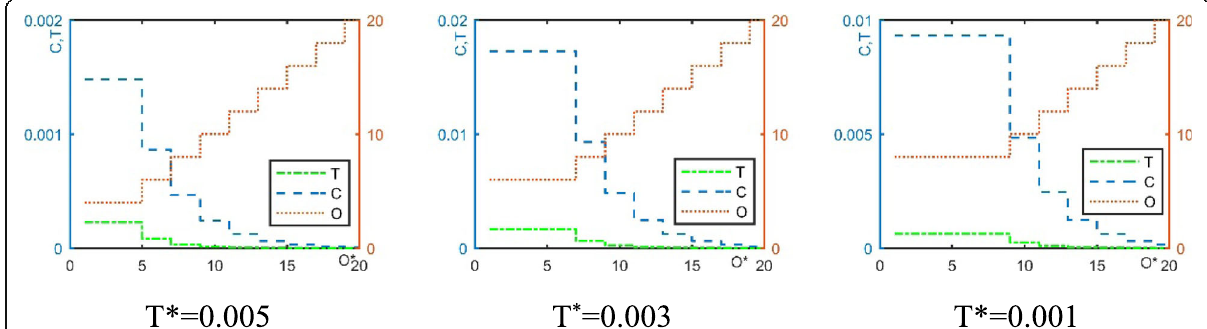
Fig. 10 Relationships among the data security, data survivability, and user storage overhead under various O* and T* constraints for n = 50 and 10 ≤ m ≤ 30